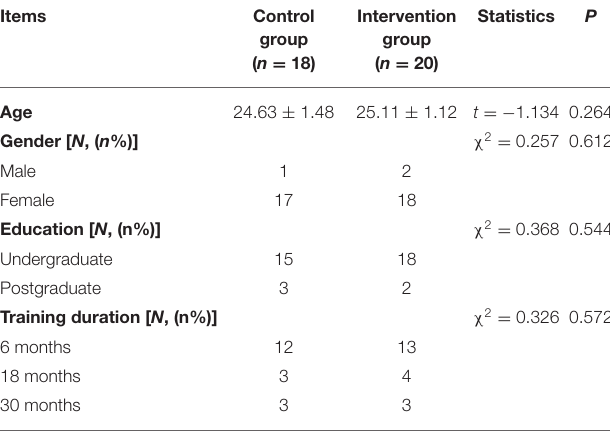
TABLE 1 | Characteristics of residents in the two groups.